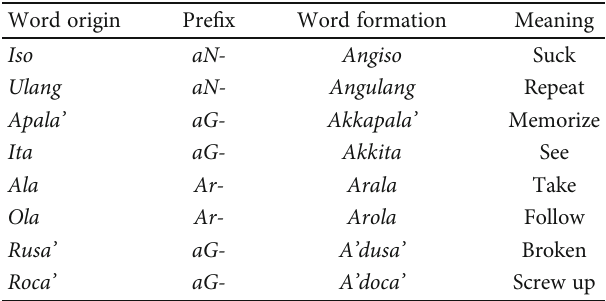
Table 2: Word formation with pre fi x a- in Bugis